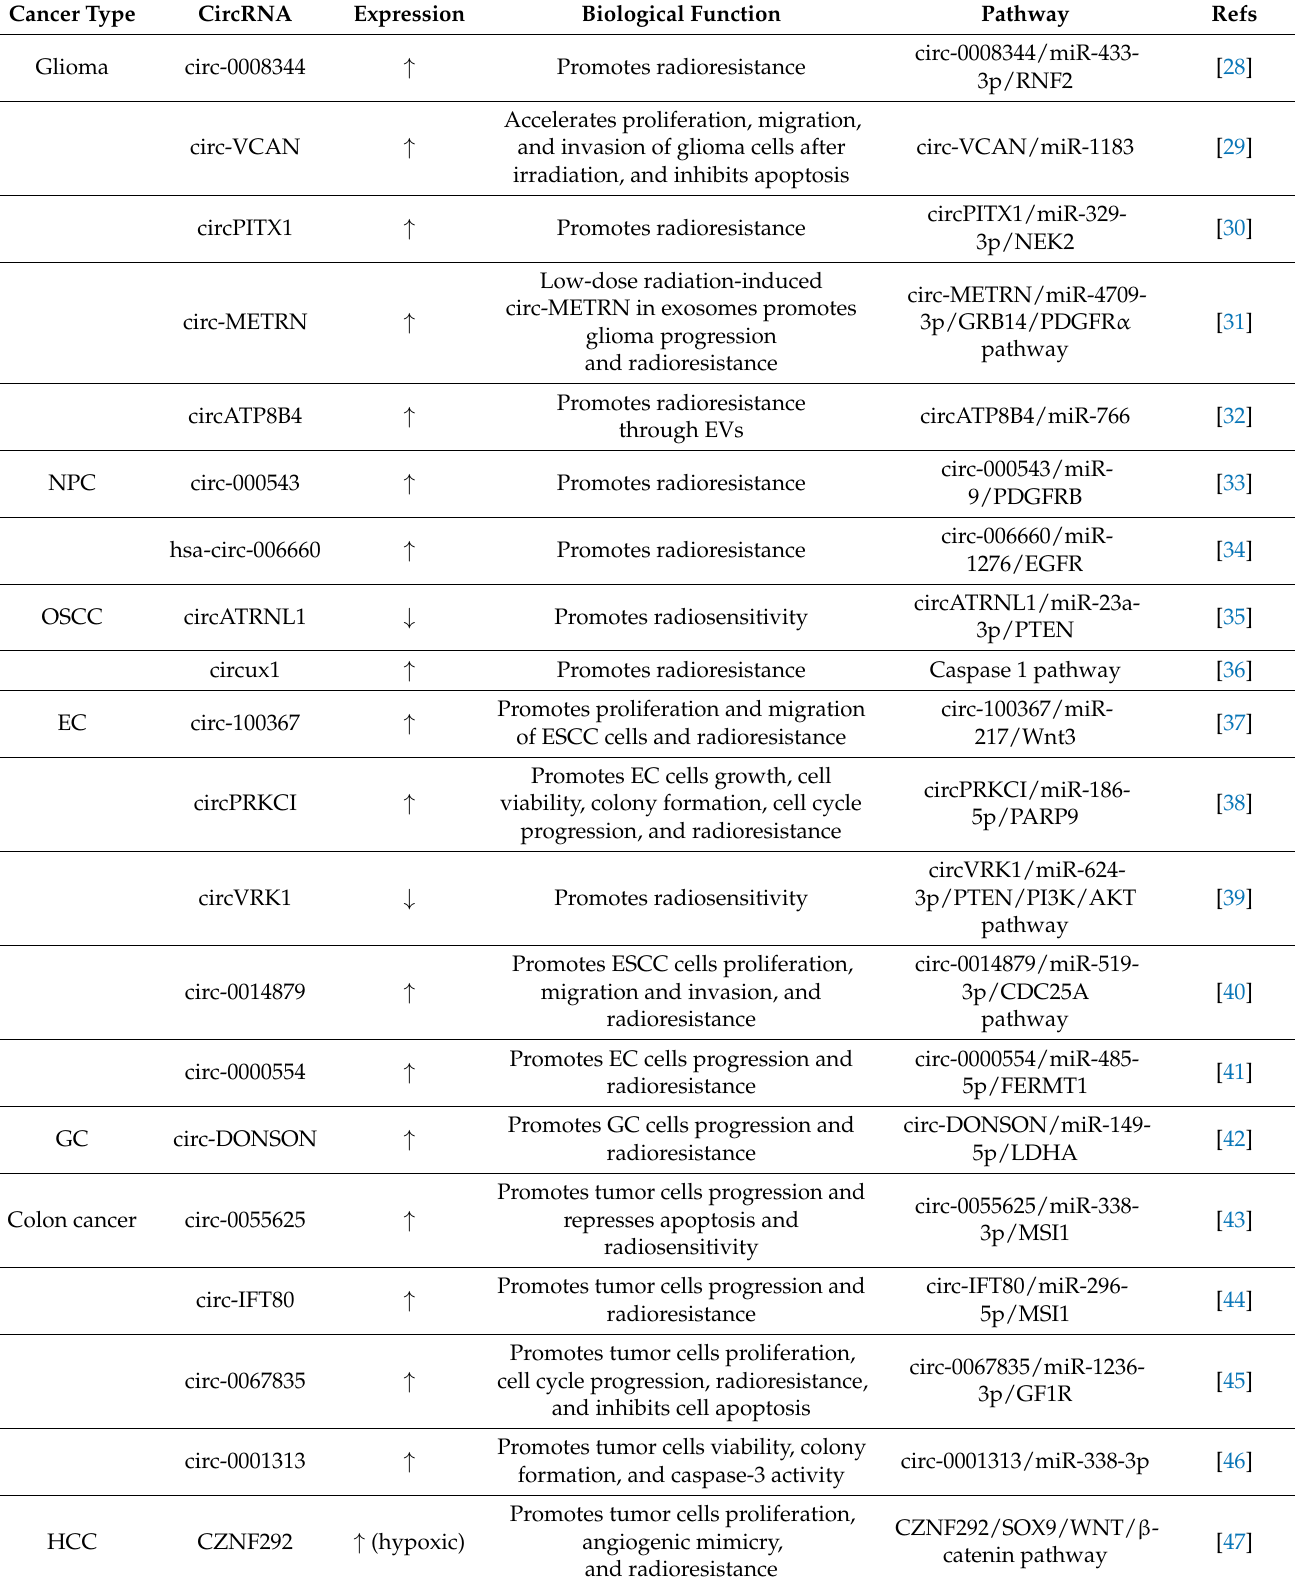
Table 1. Mechanism and function of circular RNAs in regulating solid tumor